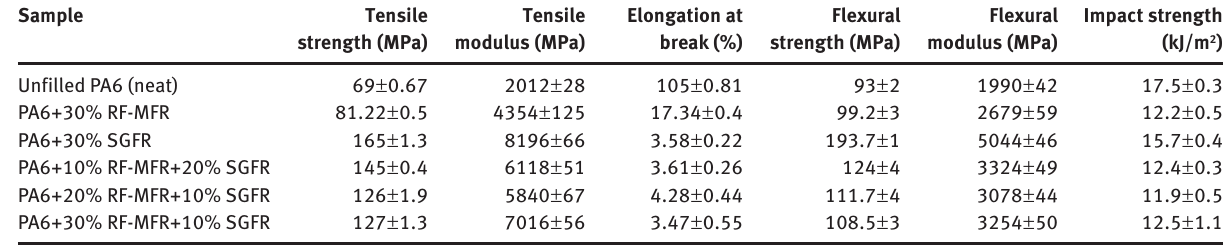
Table 5 Mechanical properties of neat PA6, single fiber-reinforced composite, and hybrid reinforcement composites.